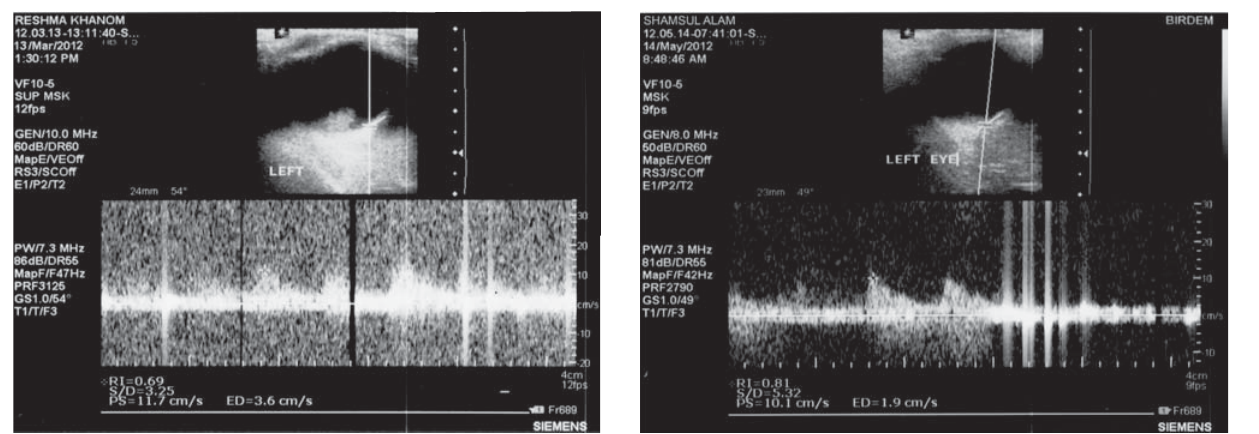
Fig 4. Spectral Doppler flow patterns of retinal artery of left eye in a type 2 diabetic